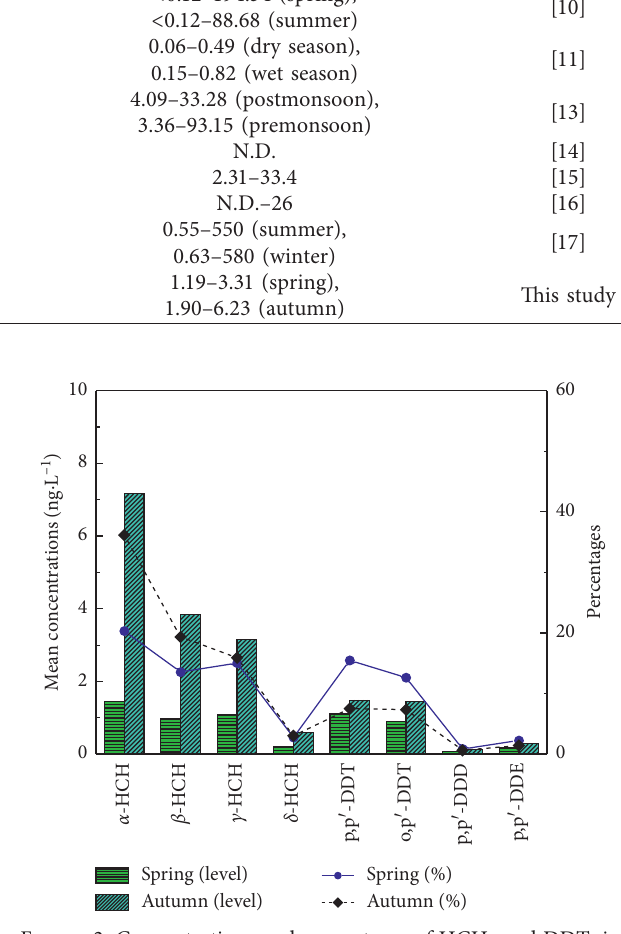
Figure 2: Concentrations and percentages of HCHs and DDTs in surface water from Jiuxi